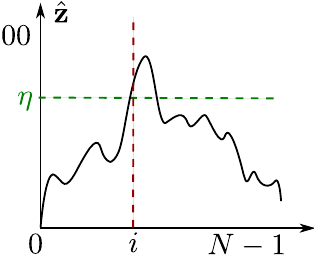
≥ η in the global confidence vector ˆ z i